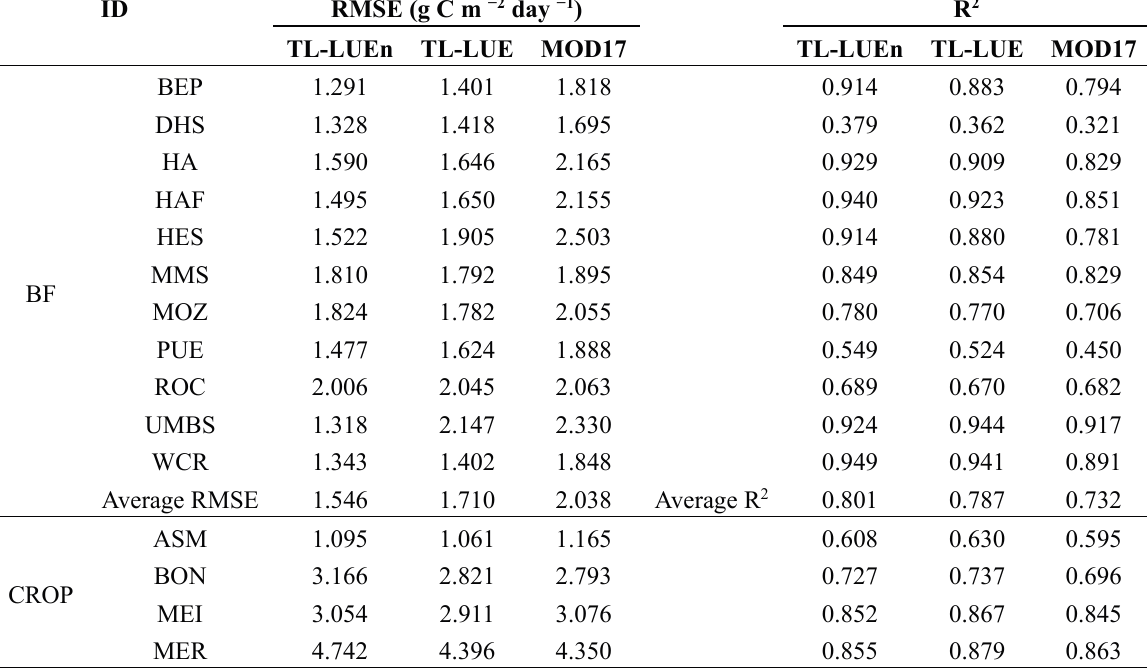
Table A2. Assessment of daily GPP simulated using TL-LUEn, TL-LUE and MOD17 for the 58 evaluation